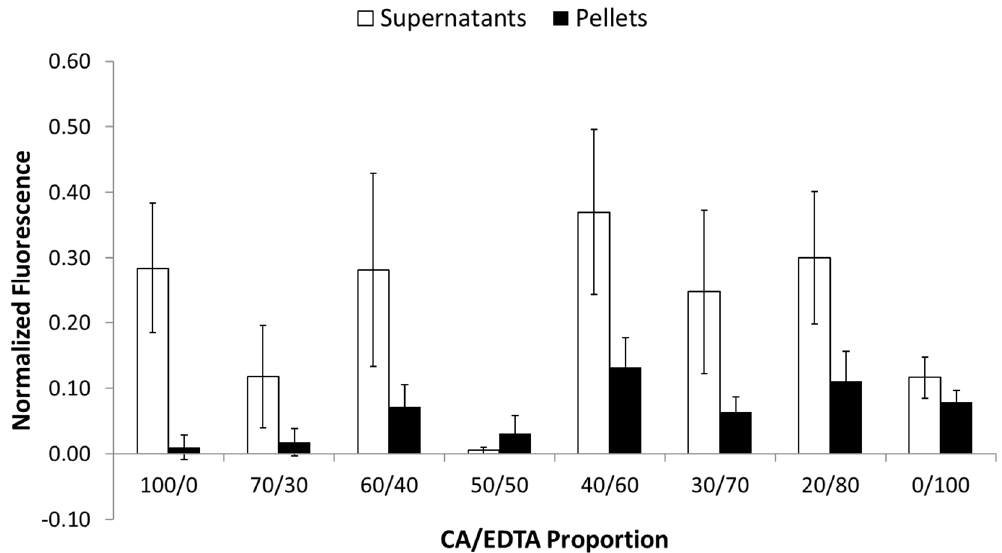
Figure 2. CeNPs stabilized with various ratios of CA/EDTA displayed significantly lower oxidase activity in the pellet compared to the supernatant fractions. Oxidase-mimetic activity of each CeNP formulation (6.5 mM) was assessed using a commercial kit, and data were normalized to 10 μ m H 2 O 2 . Data are shown as mean ± SEM of n = 4–6 separate experiments in which each formulation was assayed in triplicate. A two-way ANOVA revealed a main e ff ect of centrifugation fraction, indicating that lower oxidase activity existed in the pellets compared to the supernatant fractions (F 1,58 = 19.29, p < 0.0001). The SOD activity kit necessitated running a wide concentration range of CeNPs (6 µ M to 4 mM) for the pellet and supernatant of each type of CeNP. Therefore, we performed assays only on the nanoparticles synthesized with CA / EDTA ratios of 100 / 0, 50 / 50, and 0 / 100. We detected SOD-mimetic activity in both the supernatant and pellet fractions of all the CeNPs tested (Figure 3). A two-way ANOVA indicated there was a significant interaction between ultracentrifuge fraction and stabilizer ratio (F 2,21 = 70.30, p < 0.0001). Post-hoc comparisons revealed an inverse relationship between with only CA demonstrated the lowest SOD-mimetic activity (mean IC 50 = 1265.7 ± 194.2 µ M) compared with CeNPs synthesized with CA / EDTA ratios of 50 / 50 and 0 / 100. The activities of CeNPs synthesized with 50 / 50 and 0 / 100 CA / EDTA ratios were not statistically di ff erent. In contrast, SOD-mimetic with that measured in the pellets of CeNPs synthesized with CA / EDTA ratios of 50 / 50 and 100 /